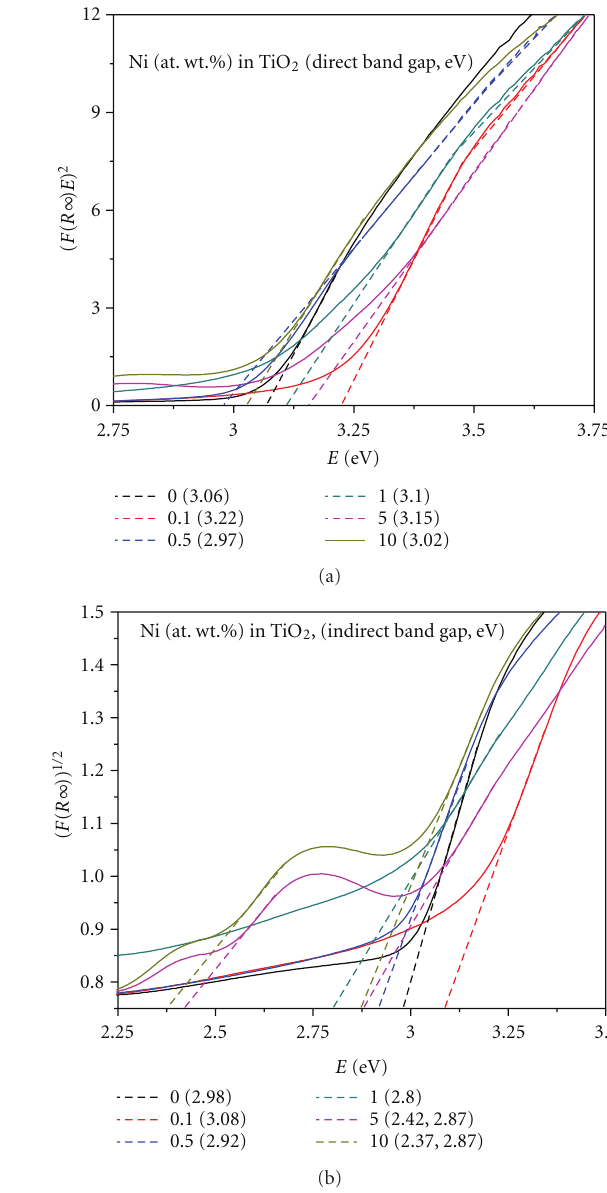
Figure 8: Transformed di ff use reflectance spectra of Ni-doped TiO 2 (Ni = 0, 0.1, 0.5, 1, 5, and 10 at. wt.%) powders formed at 550 ◦ C for 6 h showing direct bandgap (a) and indirect bandgap (b) energy